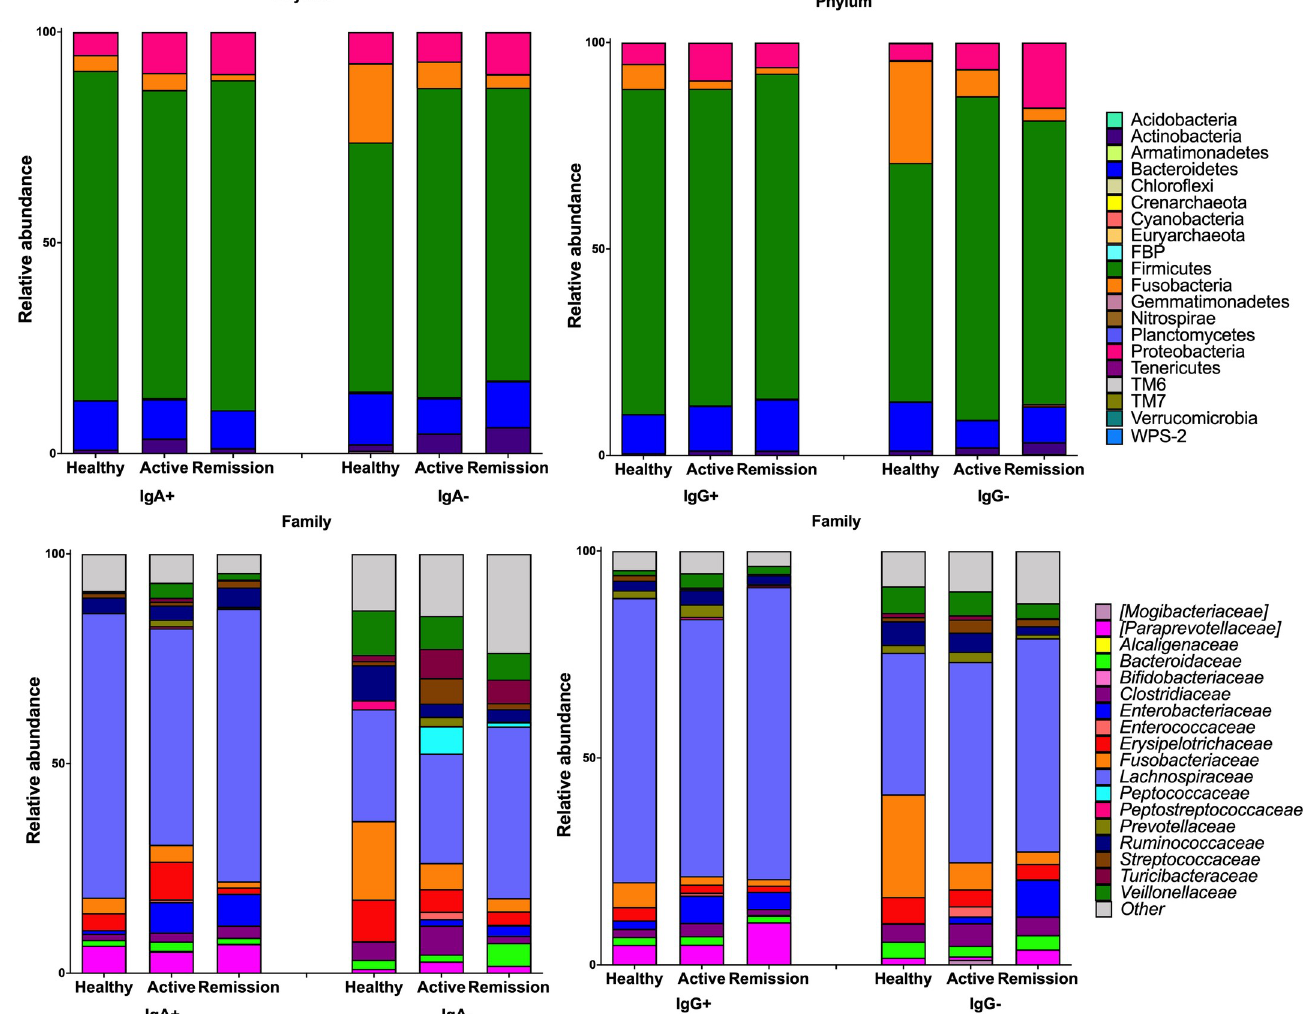
PLOS ONE | https://doi.org/10.1371/journal.pone.0255012 August 19,